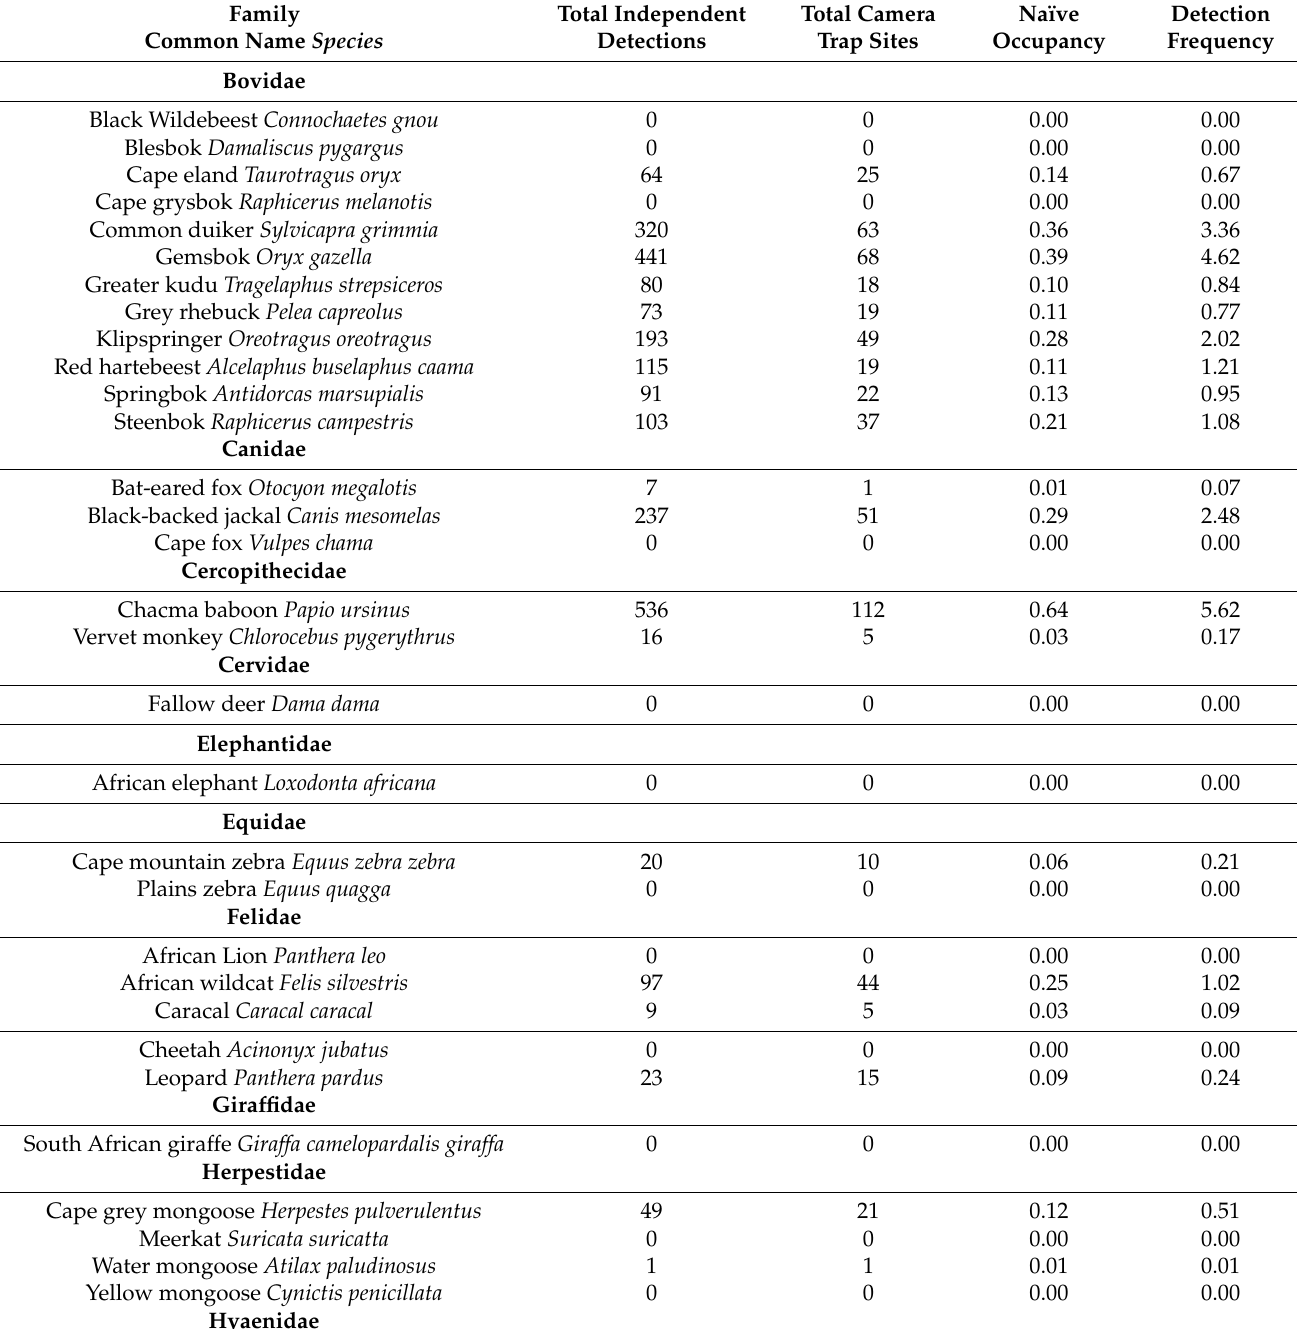
Table A3. General results of the camera trapping surveys conducted on the statutory protected area, presented per family and species. Shaded in light grey, the species/families that are absent or were not detected. Shaded in blue, the species/families that are true (i.e., known) absences. Total independent detections indicate the sum of independent detections, and the naïve occupancy is the proportion of camera trap sites at which the species was detected. The detection frequency (or relative abundance index [RAI]) is the camera trapping